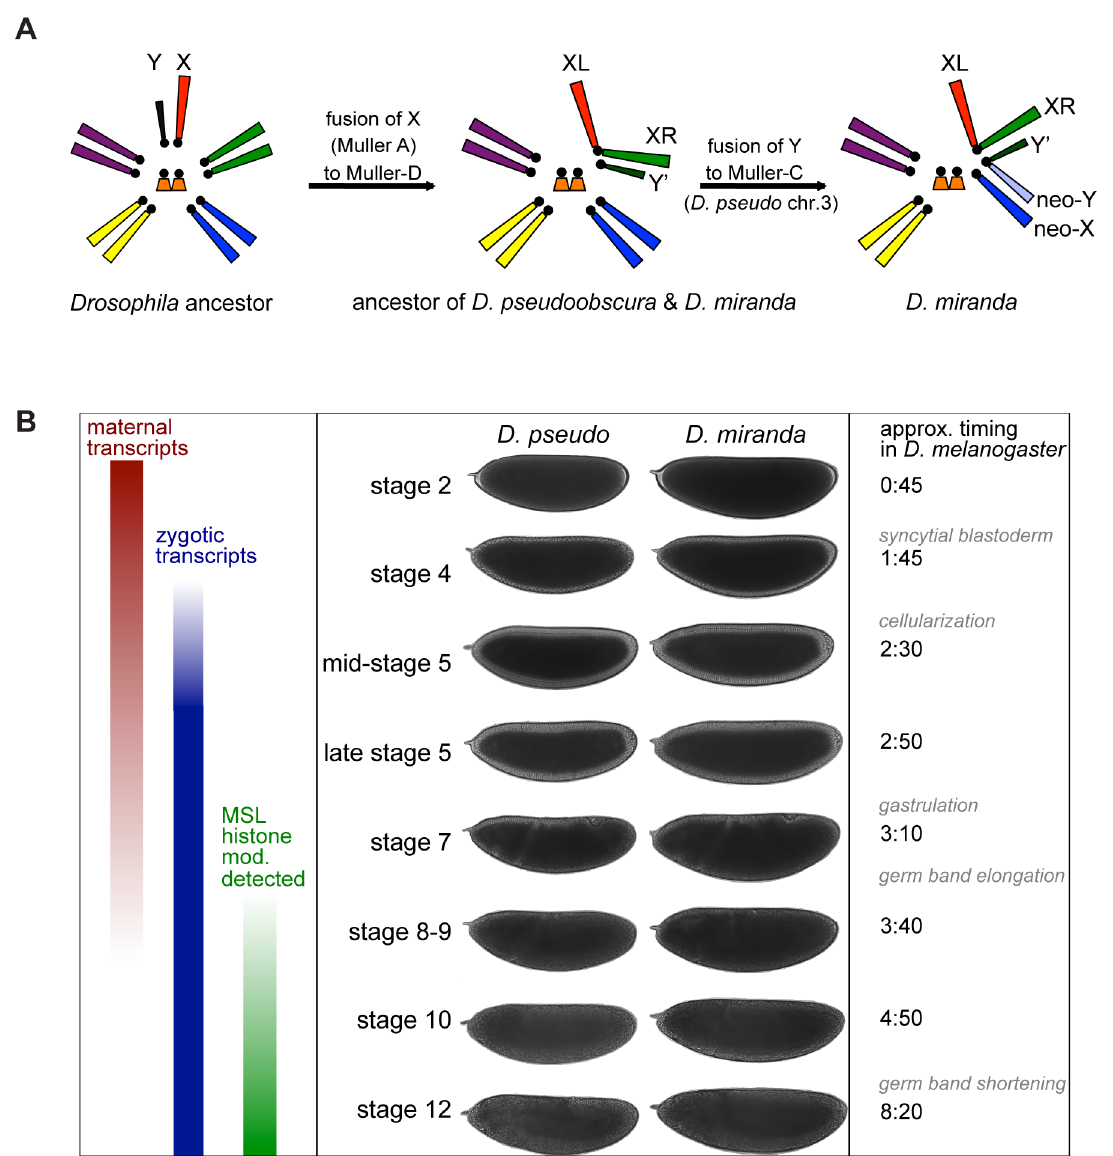
Figure 1. Karyotype and timecourse. A) Karyotype of a Drosophila ancestor, D. pseudoobscura and D. miranda ancestor (and current karyotype of D. pseudoobscura ), and D. miranda . B) Important transcriptional events in the early embryo, examples of embryo staging for the two species, based on morphology, and timing of these events in D. melanogaster at 25 u C. MSL histone modification (mod.) refers to observation of the histone modification H4K16ac, mediated by the MSL complex, by antibody staining in D. melanogaster